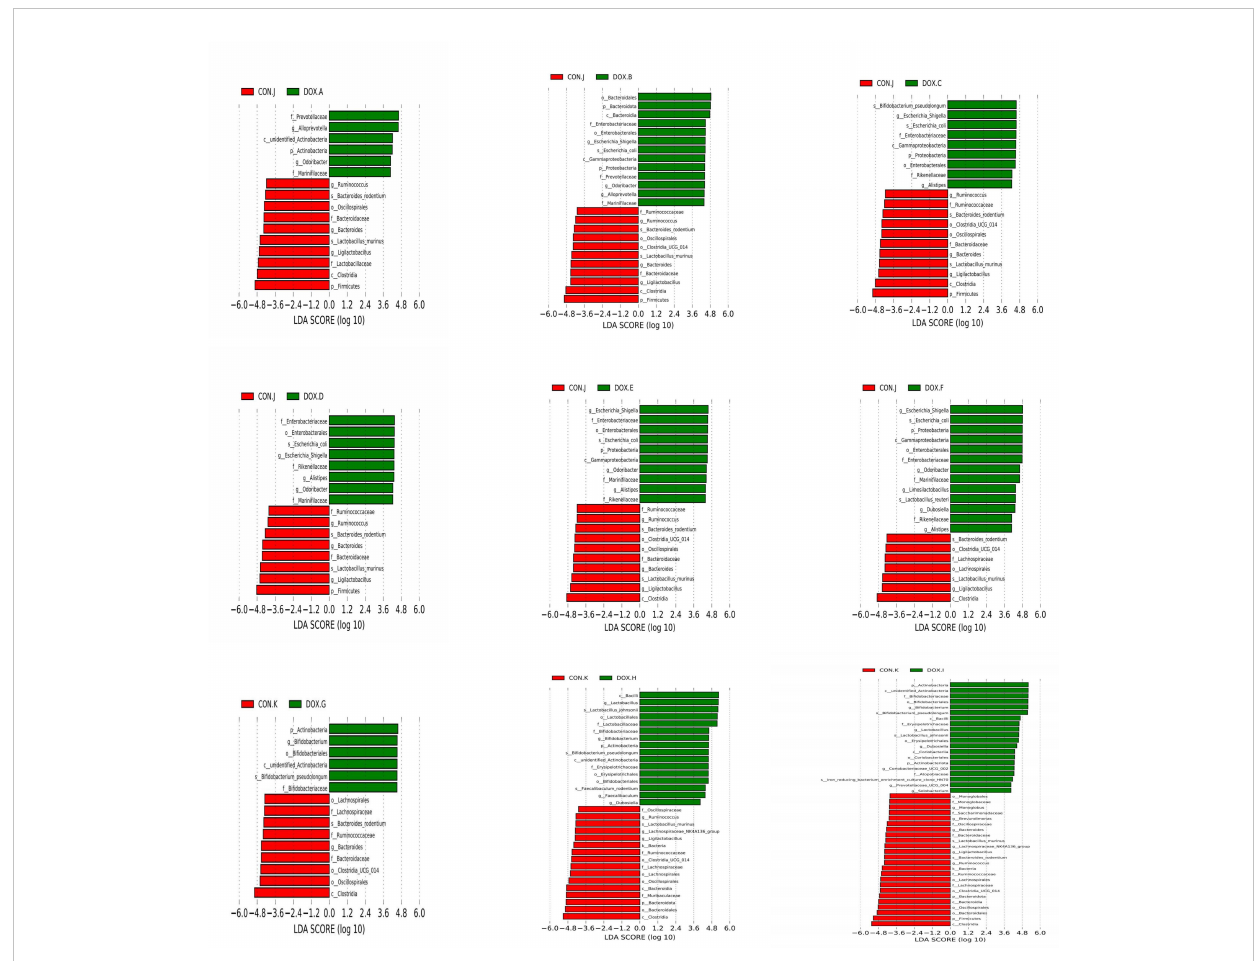
FIGURE 9 Cladogram analyzed by LEfSe (LDA = 4.0, P < 0.05) showing the phylogenetic distribution of the bacterial lineages in CON group and DOX group. CON, control; DOX, doxorubicin; LDA, linear discriminant analysis; LEfSe, linear discriminant analysis effect size. n =